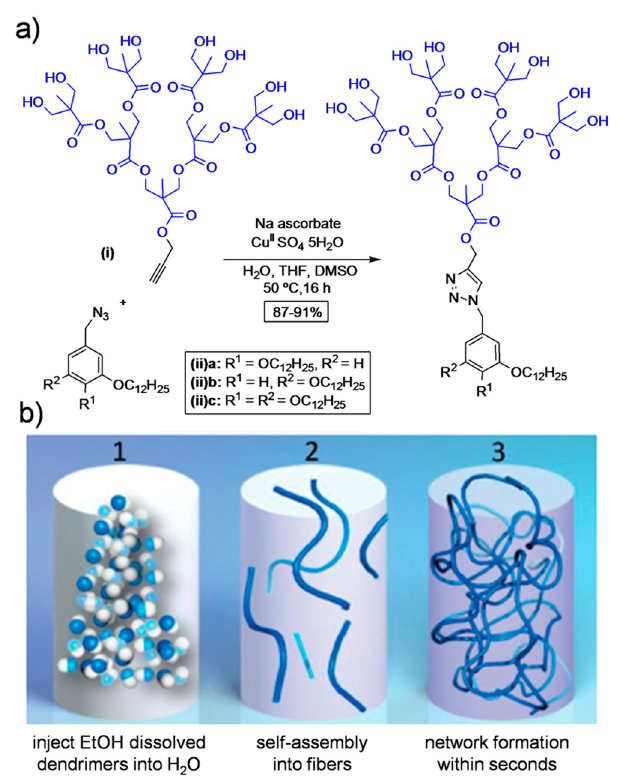
Figure 6. ( a ) Structure and synthesis of amphiphilic Janus dendrimers; ( b ) hierarchical self-assembly of dendrimers to form fibers and hydrogel. From [21], Copyright © 2015 by John Wiley & Sons, Inc. Adapted by permission of John Wiley & Sons, Inc.